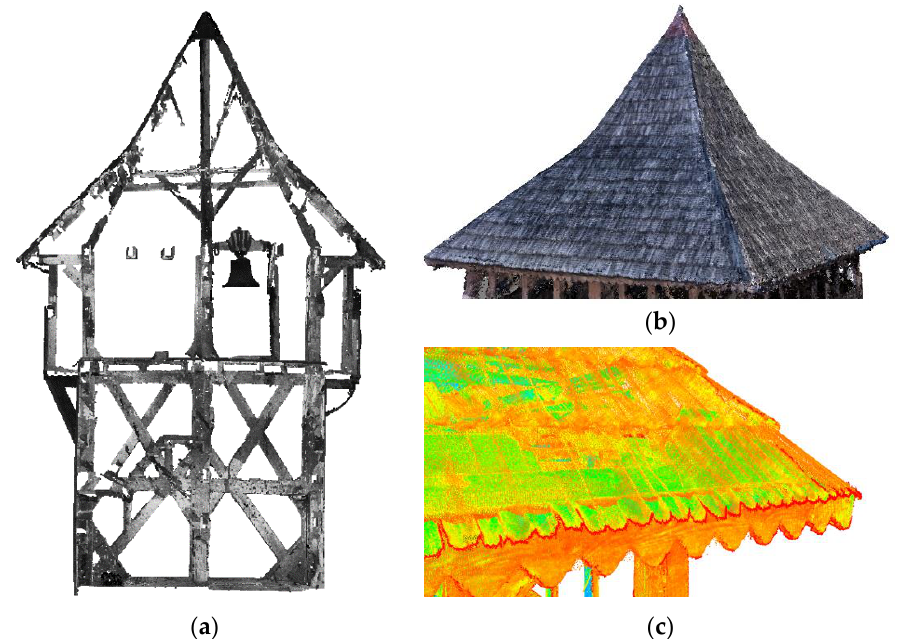
Figure 7. Identification of objects on a point cloud: construction of building ( a ), deformations and gaps on the roof ( b ), finishing, e.g., decorations ( c ).